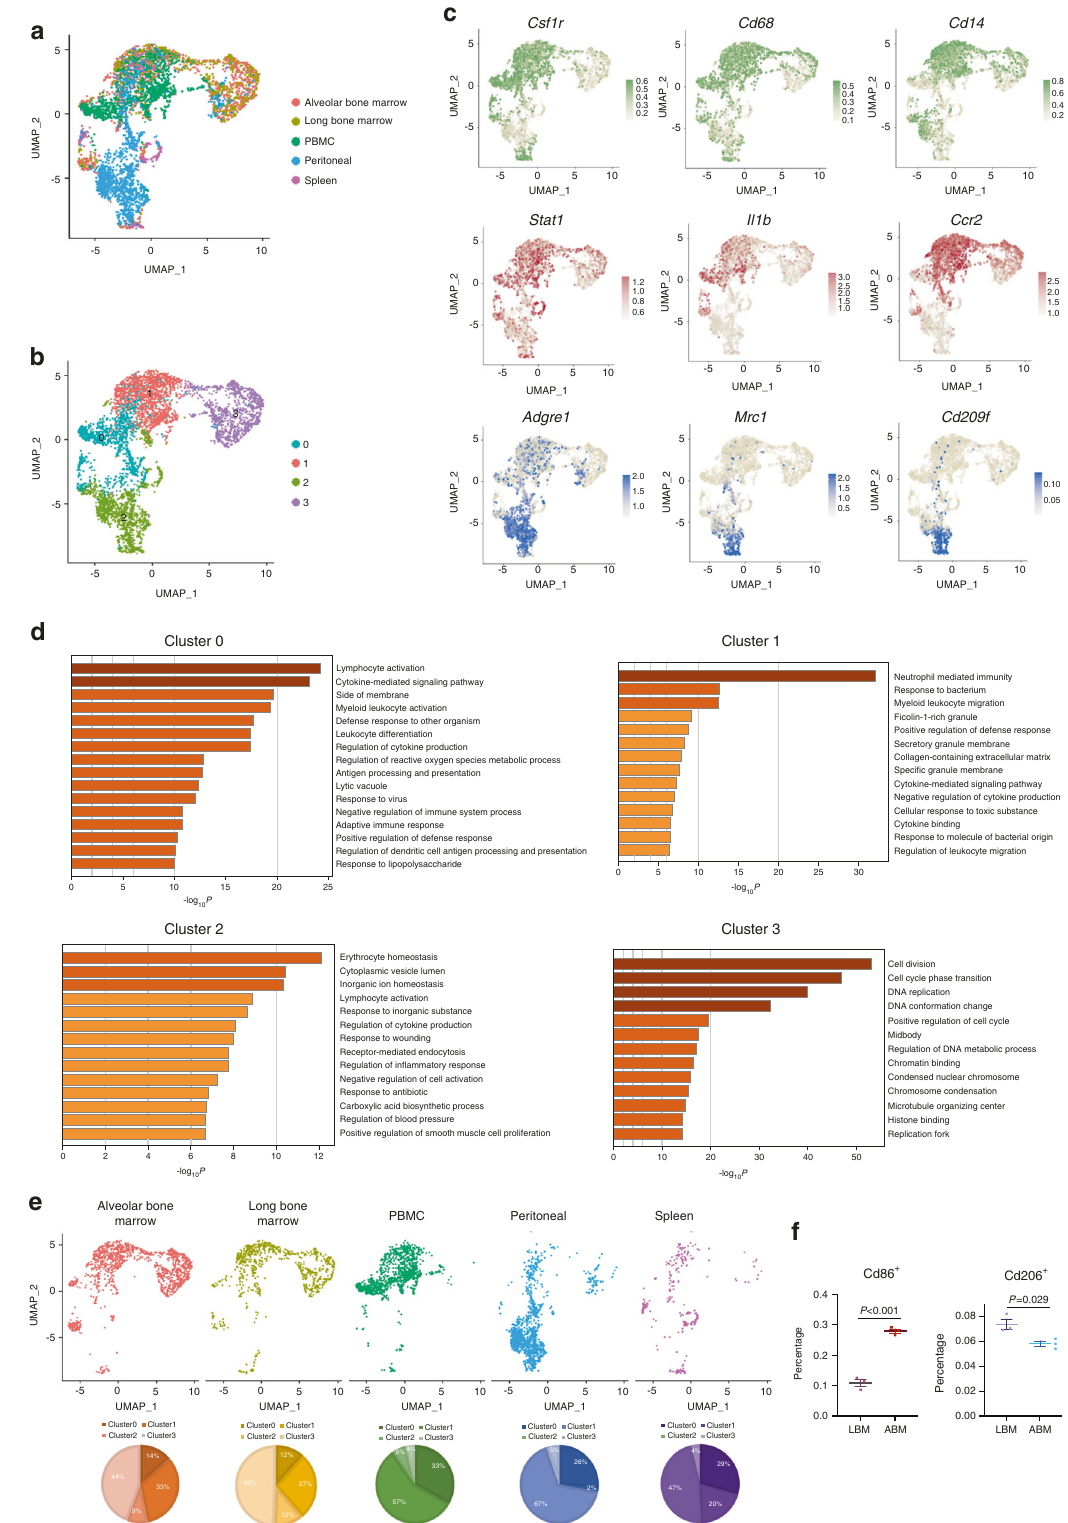
Fig. 3 Comparative analysis of the heterogeneity of monocytes/macrophages. a Monocyte/macrophage population after merging fi ve scRNA- seq datasets was visualized with umap plot. b Identi fi cation of the 4 subclusters of Monocyte/Macrophage population. c The expression of classic macrophage polarization markers in monocyte/macrophage population. d GO enrichment analysis of the biological functions of different subclusters. e Distribution of cells on umap plot split by tissue origins. f Flow cytometry analysis of the ratio of Cd86 + and Cd206 + macrophages in alveolar bone marrow and long bone